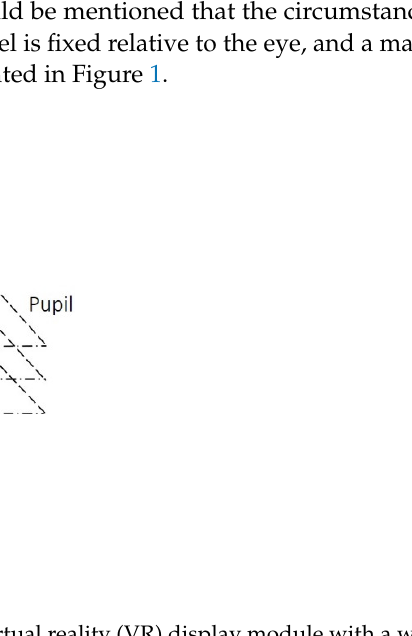
Figure 1. Illustration of a typical virtual reality (VR) display module with a wide-view display. From the system viewpoint, applying a direct-view display panel in VR headsets may result in several issues that affect users’ experience. Firstly, direct-view display panels emit light within a large solid angle, while in VR headsets, only the light rays radiating from a small solid angle can reach the pupil, as depicted in Figure 1. As a result, a considerable amount of display light is wasted. This issue is more critical in VR headsets with catadioptric (pancake) optics where the lens transmittance is already lower than 25%. Secondly, the stray rays outside the effective solid angle cannot enter the exit pupil. These rays may bounce back and forth between the VR lens and the display panel, causing background noise and reducing the contrast ratio of front-of-screen imagery. In addition, direct-view display panels usually manifest higher luminance in the direction normal to the panel surface, which leads to a relatively darker peripheral field, i.e., vignetting. The spatial varying size and orientation of the effective solid angle also exaggerate the luminance variation across the field of view (FOV). Last but not least, for OLEDs, the microcavity utilized in RGB pixels can narrow the emission spectra but may also cause color shift across the viewing angle due to the variance in RGB Fabry–Perot resonance [6]. In a VR headset, this angular color shift can lead to apparent color variation across the FOV. Because of the abovementioned issues, the wide-view display panel is not an ideal choice for VR displays.